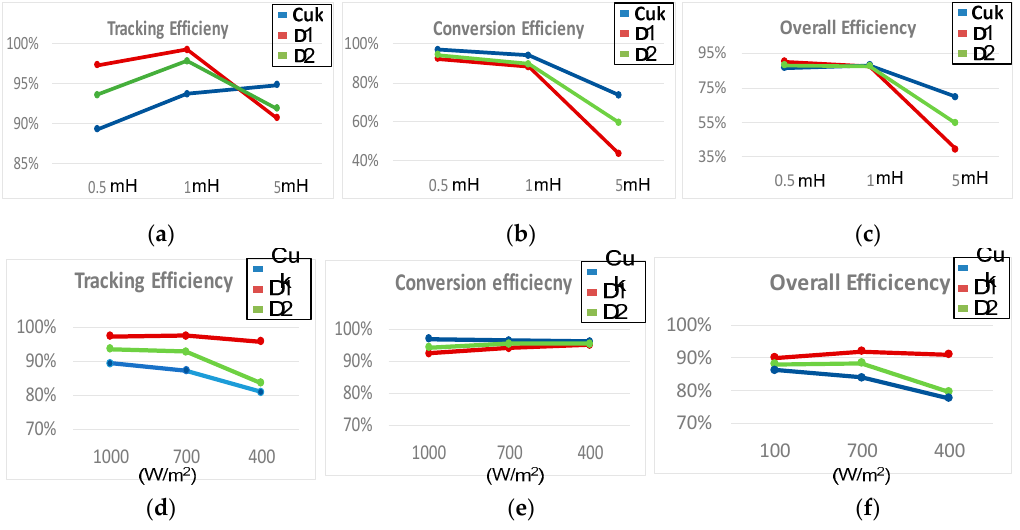
Energies 2019 , 12 , x FOR PEER REVIEW 20 of 28 pattern has dominant effect resulting in converters’ overall efficiencies with the same pattern where the D1 converter shows the highest overall efficiency for all power levels. Figure 6. D2 PV power and average load power for: ( a ) 0.5 mH; ( b ) 1 mH; ( c ) 5 mH.